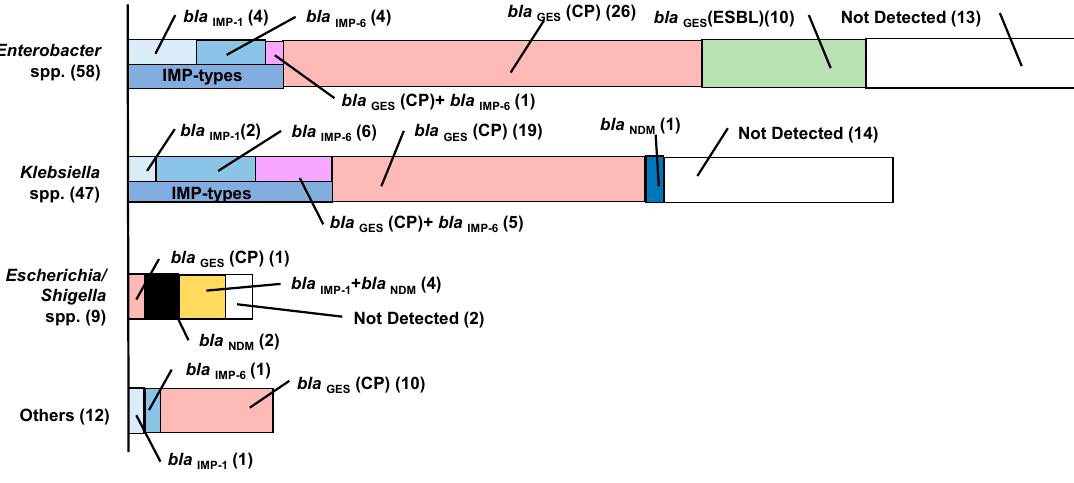
Figure 4. Gene encoding carbapenemase.